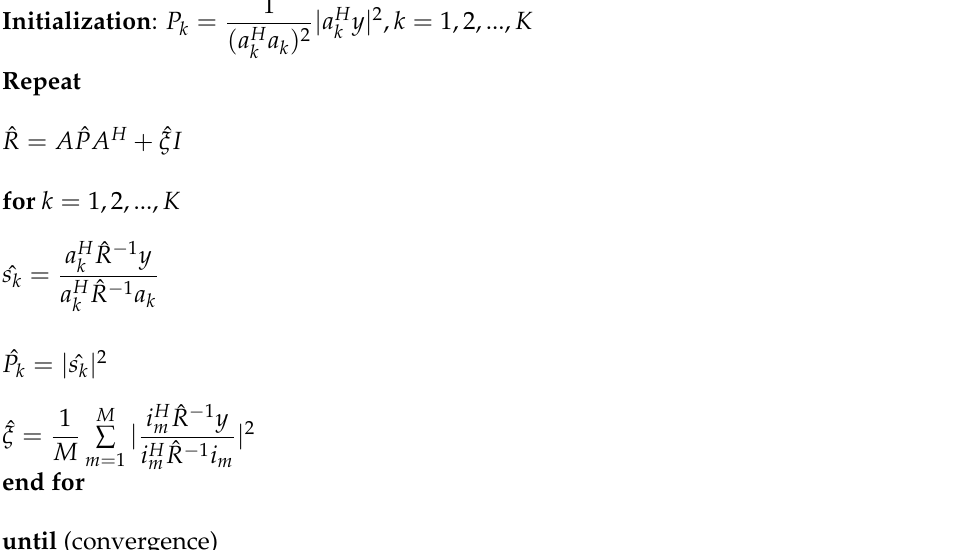
Algorithm 1 Interference suppression and super-resolution algorithm based on